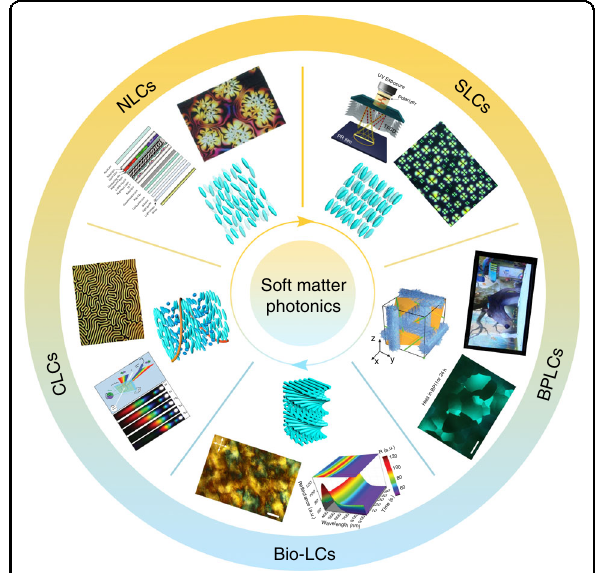
Fig. 1 Soft matter photonics. Schematic structures, representative textures, and promising applications of soft matters including nematic phase LCs 6,7 (Reproduced from refs. 6,7 , with permissions from John Wiley & Sons and AAAS), smectic phase LCs 96 (Reproduced from ref. 96 , with permission from Wiley-VCH), cholesteric phase LCs 296,297 (Reproduced from refs. 296,297 , with permissions from Wiley-VCH), blue phase LCs 144,298,299 (Reproduced from refs. 298,299 , with permissions from Wiley-VCH. Reproduced from ref. 144 , with permission from Springer Nature: Nature Communications), and bio-based LCs 183,203 (Reproduced from refs. 183,203 , with permissions from Springer Nature: Nature Communications and